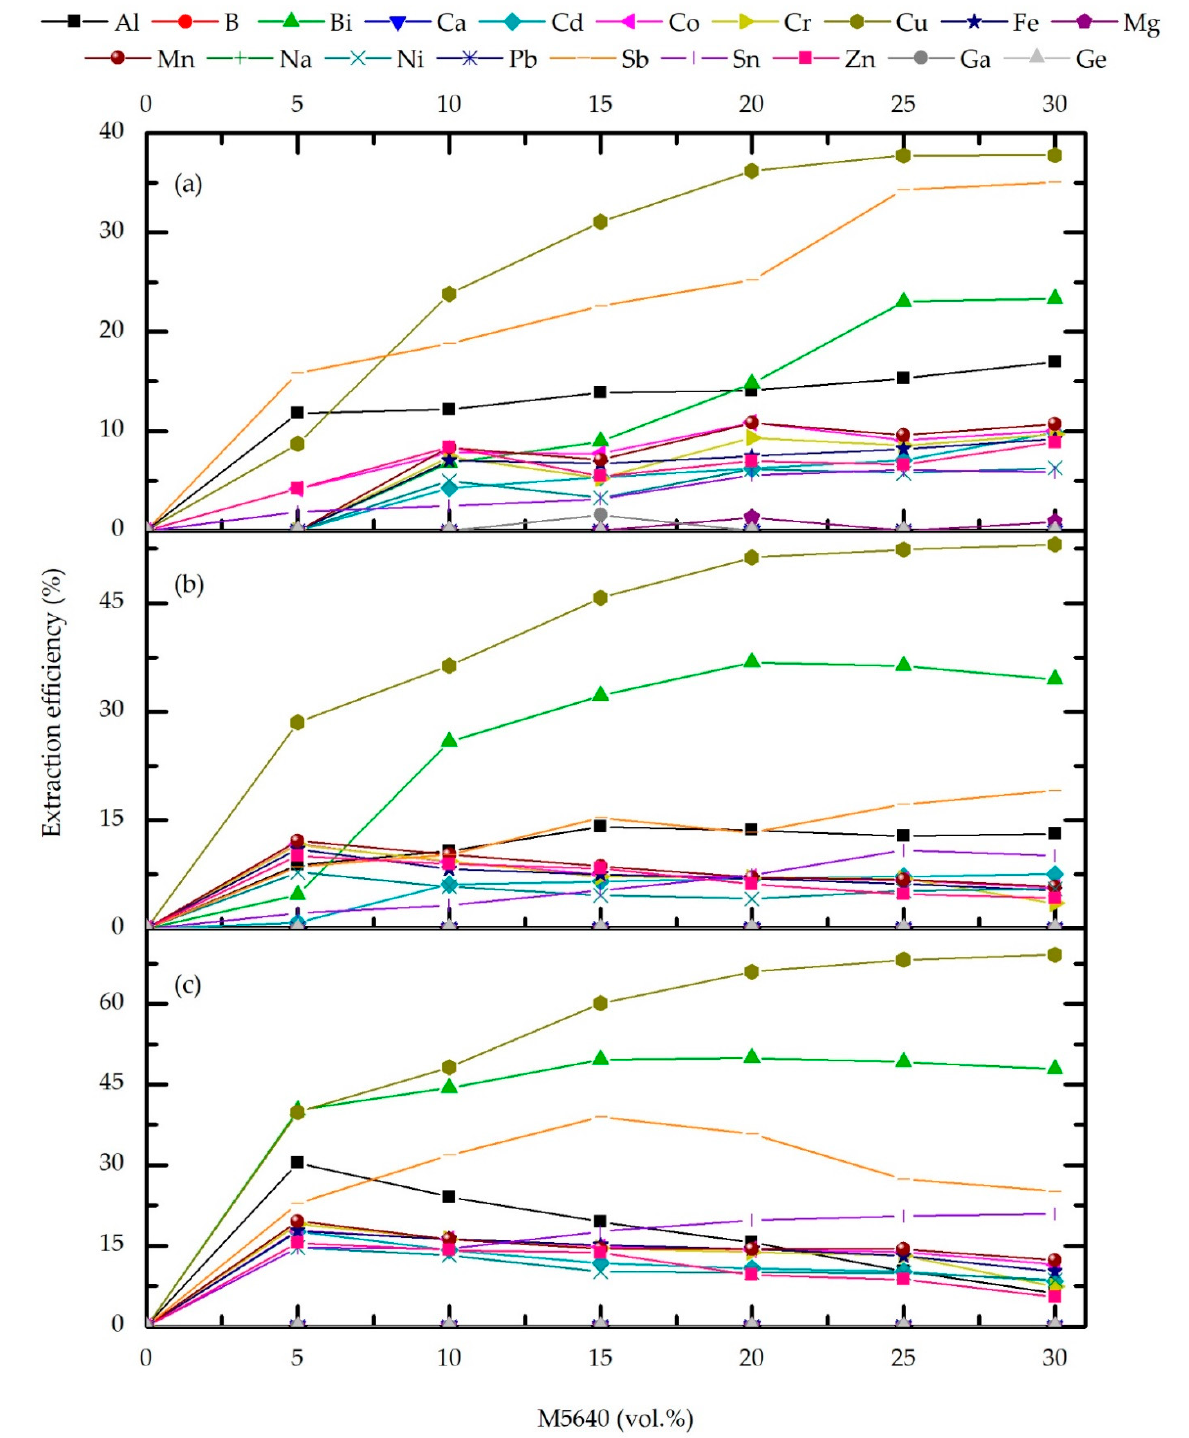
Figure 2. Effect of M5640 concentration and O/A phase ratio 4 ( a ), 3 ( b ), and 2 ( c ) on extraction efficiency for the feed pH 0, temperature 20 °C, and contact time 10 min.